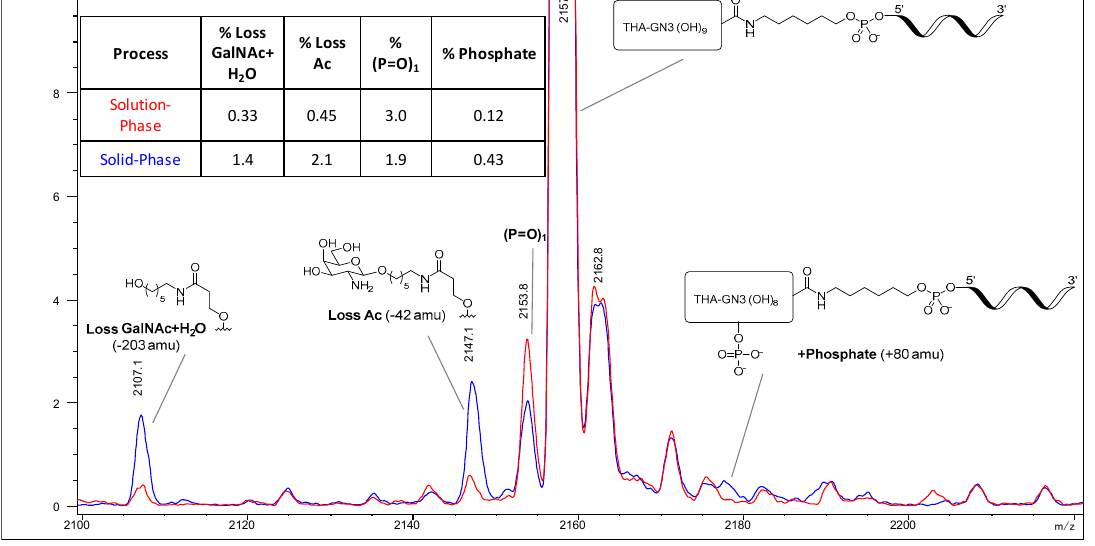
Figure 7. Overlay of average mass spectrum under main UV peaks from the solution-phase process (red) and the solid-phase process (blue).